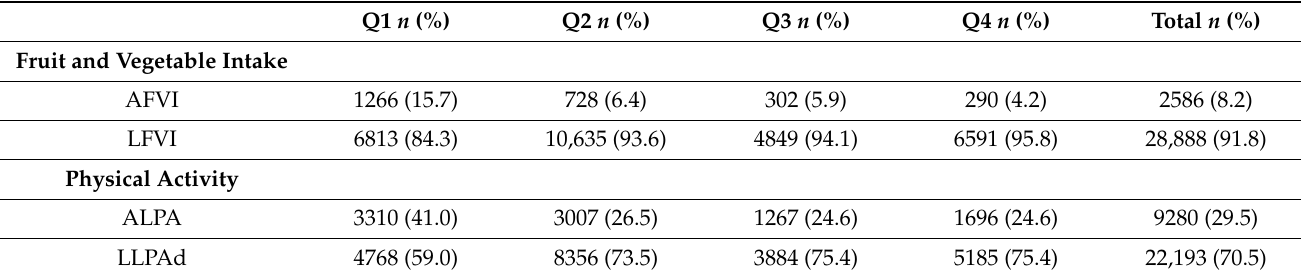
Table 2. Prevalence of chronic diseases and risk factors in the weighted sample over the quarters of